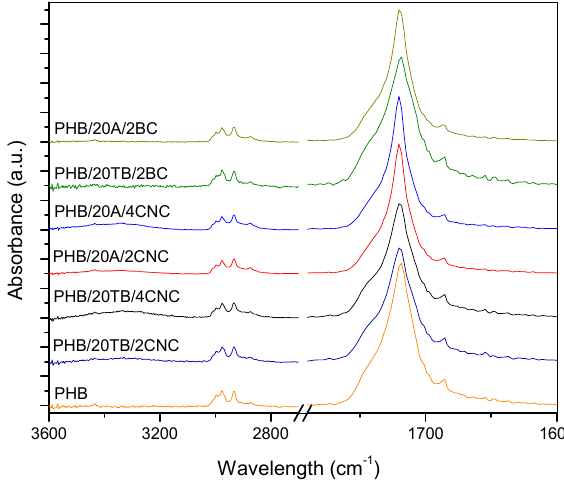
Figure 3. FTIR spectra of PHB ternary composites.